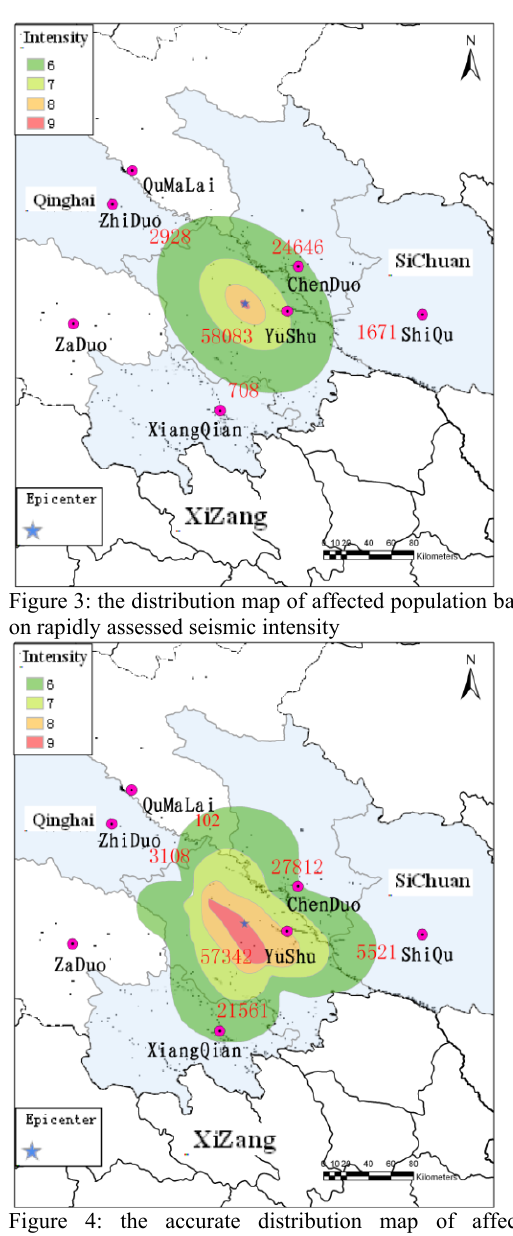
Figure 4: the accurate distribution map of affected population